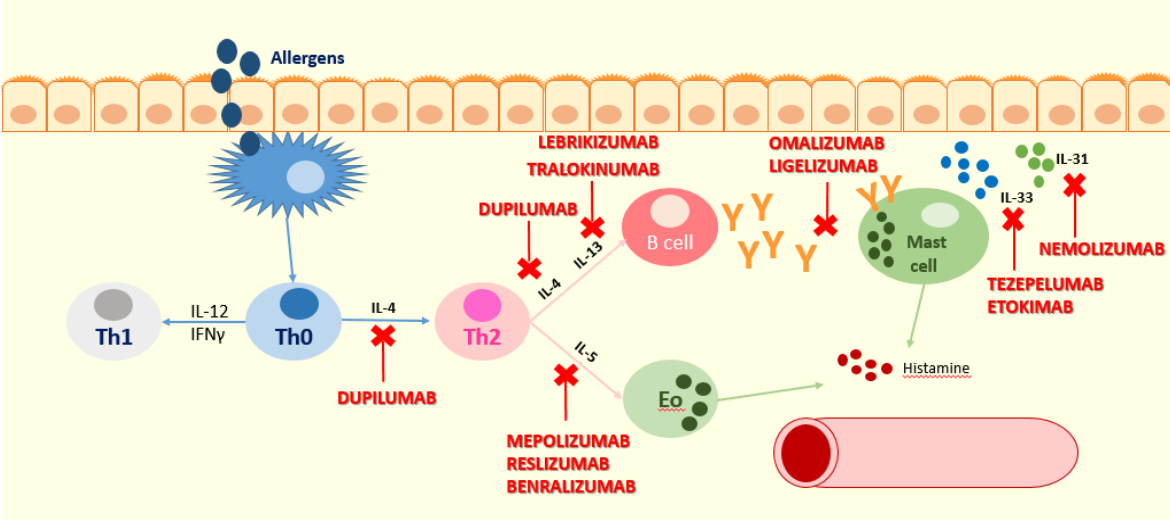
Figure 1. The point of action of the inhibitory activity of the mentioned biologic drugs. Dupilumab acts against the alpha subunit of the IL-4 receptor (IL4R α ), blocking IL-4 and IL-13 receptors and, therefore, the type-2 inflammation pathway. Mepolizumab is an anti-IL-5 antibody and acts by blocking Th2 cytokine expression mediated by IL-5 and eosinophils. Tezepelumab binds TSLP, preventing its interaction with the receptor complex, and etokimab binds IL-33; therefore, tezepelumab and etokimab act upstream of effector Th2 cytokines such as IL-4, IL-13, and IL-31. Nemolizumab is a humanized monoclonal antibody that acts against the IL-31 receptor, and it is essential in mediating itching. Lebrikizumab and tralokinumab are monoclonal antibodies that bind soluble IL-13, preventing heterodimerization of IL-13Ra1/IL-4Ra and the following signaling, are they are implicated in the Th2 immune response. Ligelizumab and omalizumab are monoclonal antibodies that act against IgE. Benralizumab is a monoclonal antibody that acts against the IL-5-receptor